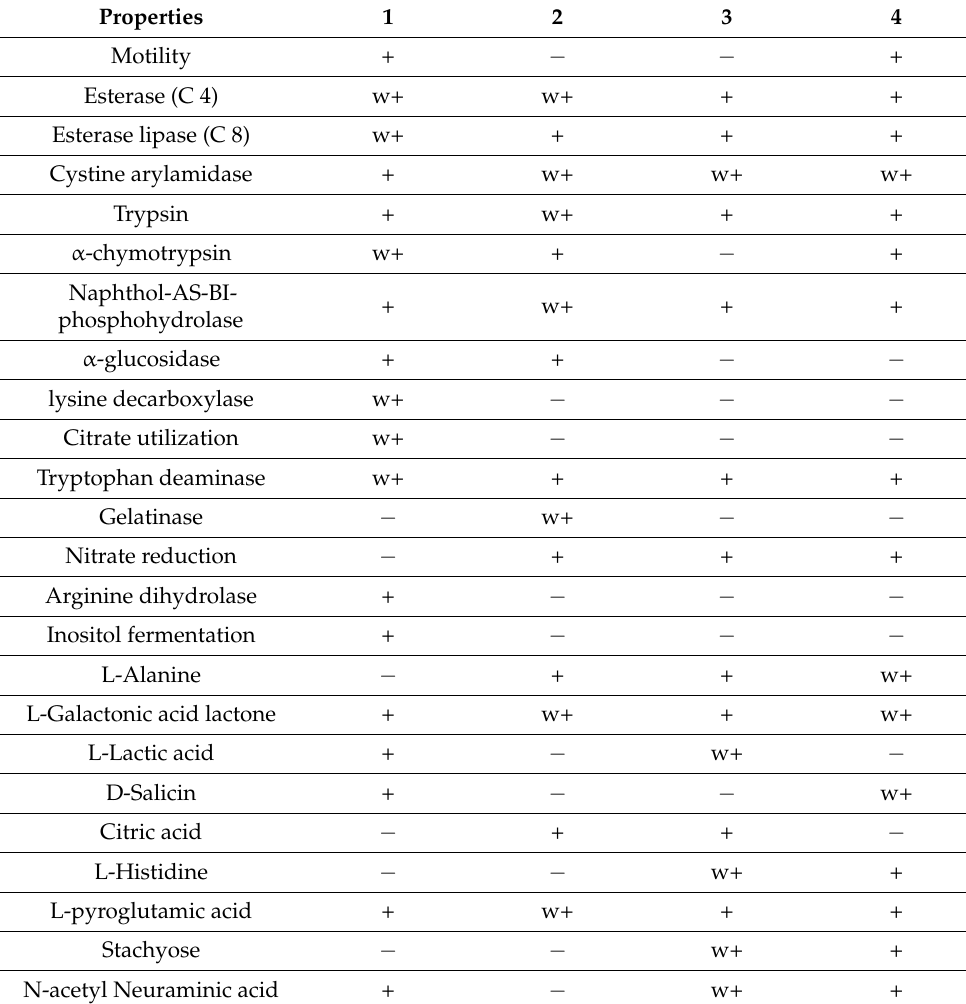
Table 3. Differential properties of strain NZ-96 T and closely related type